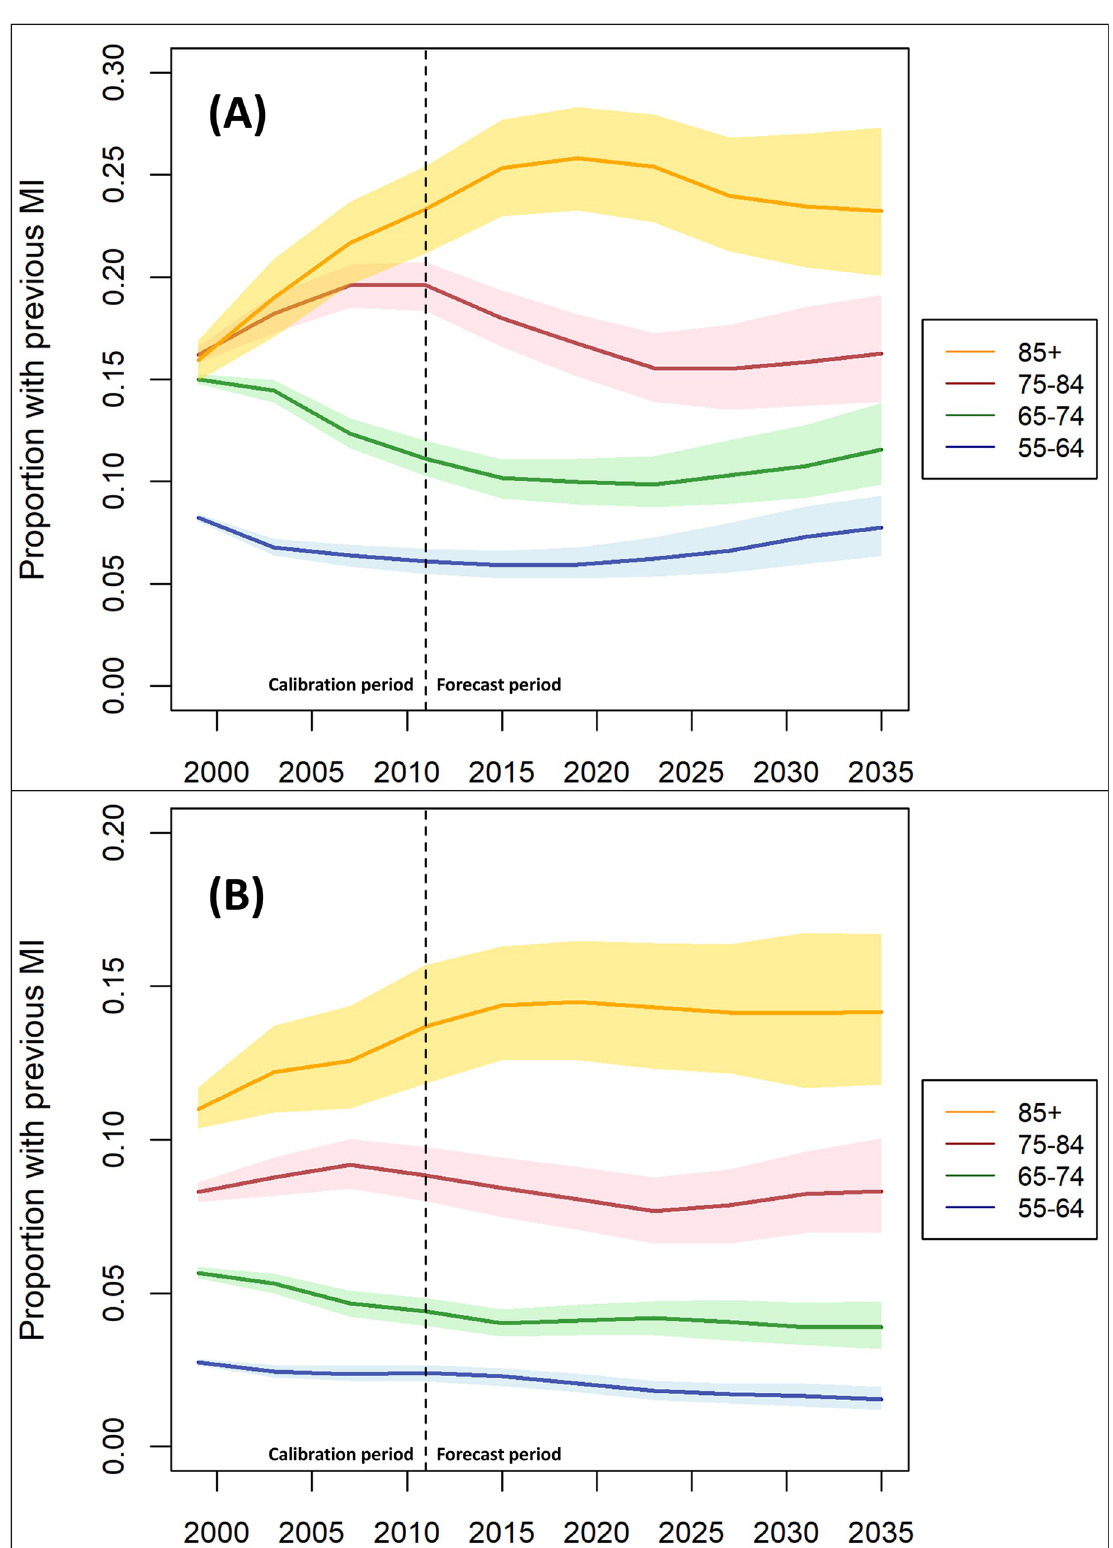
Fig 3. Modelled prevalence rates of first MI by age group for men (A) and women (B), 1998–2035.